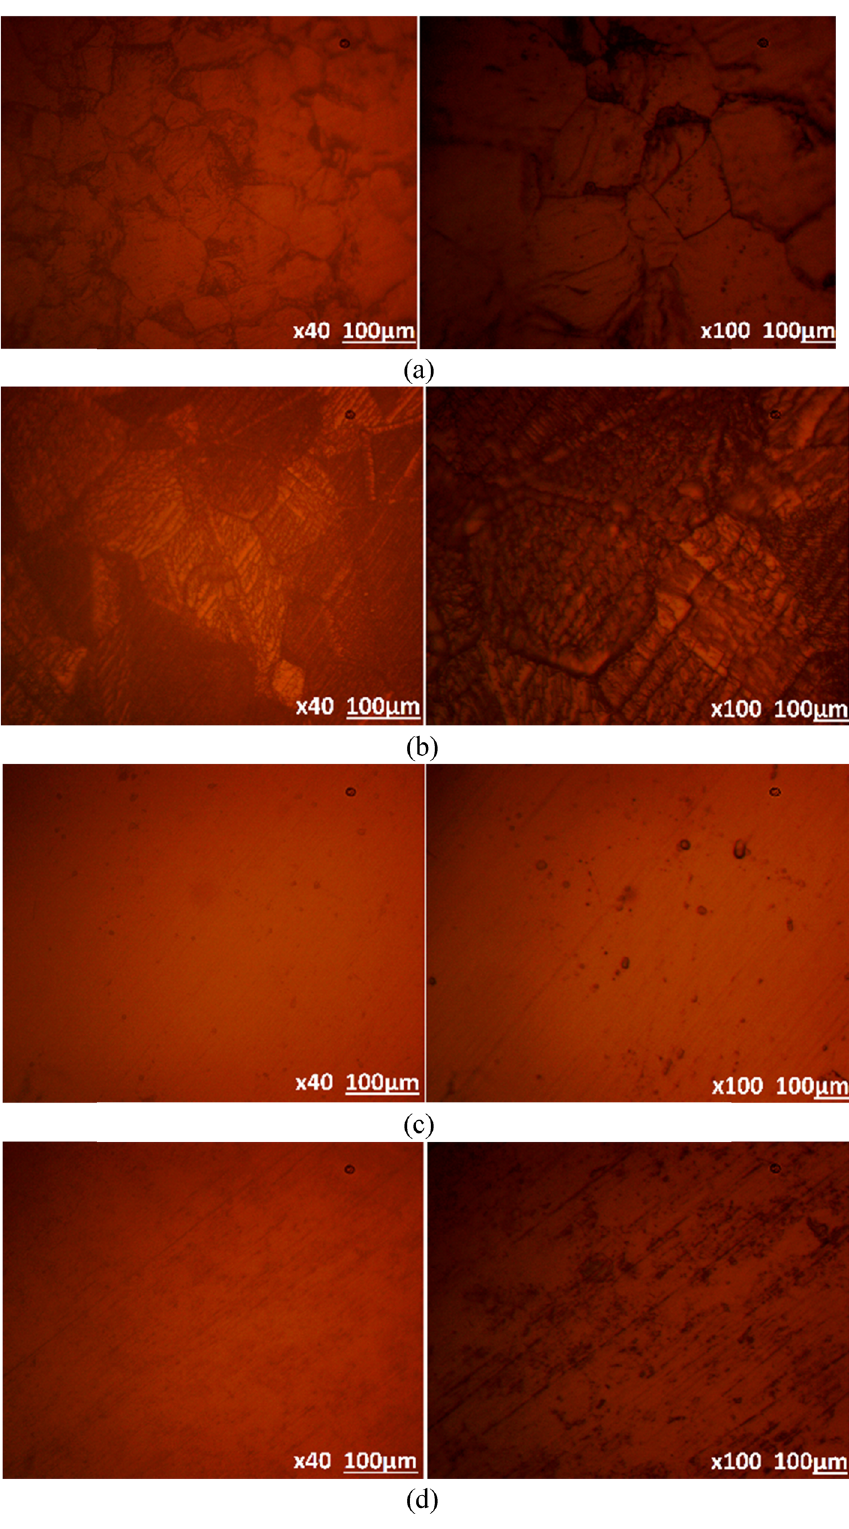
Figure 4: Optical morphology of ( a ) 439ll, ( b ) 316L, ( c ) NO7208, and ( d ) Ti6Al4V alloys following corrosion in 4 M H 2 SO 4 + 5% NaCl solution at